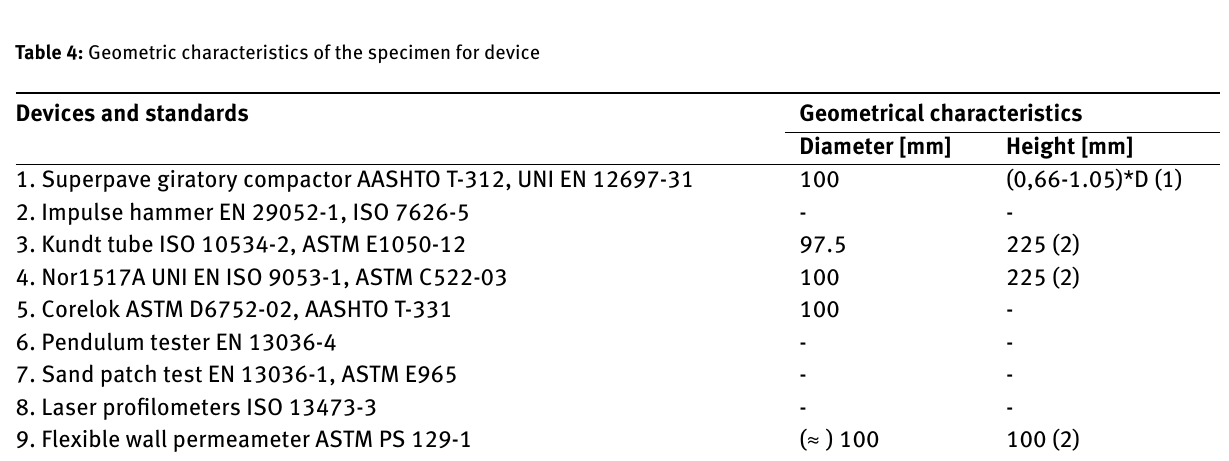
Figure 9: Processes and parameters